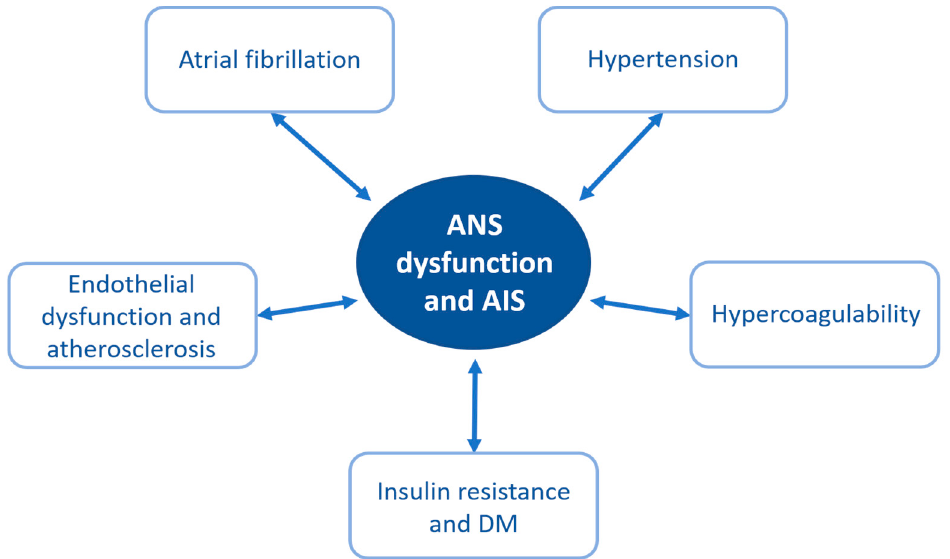
Figure 1. Risk factors for stroke and autonomic dysfunction. Abbreviations: ANS, autonomic nervous system; AIS, acute ischemic stroke; DM, diabetes mellitus.